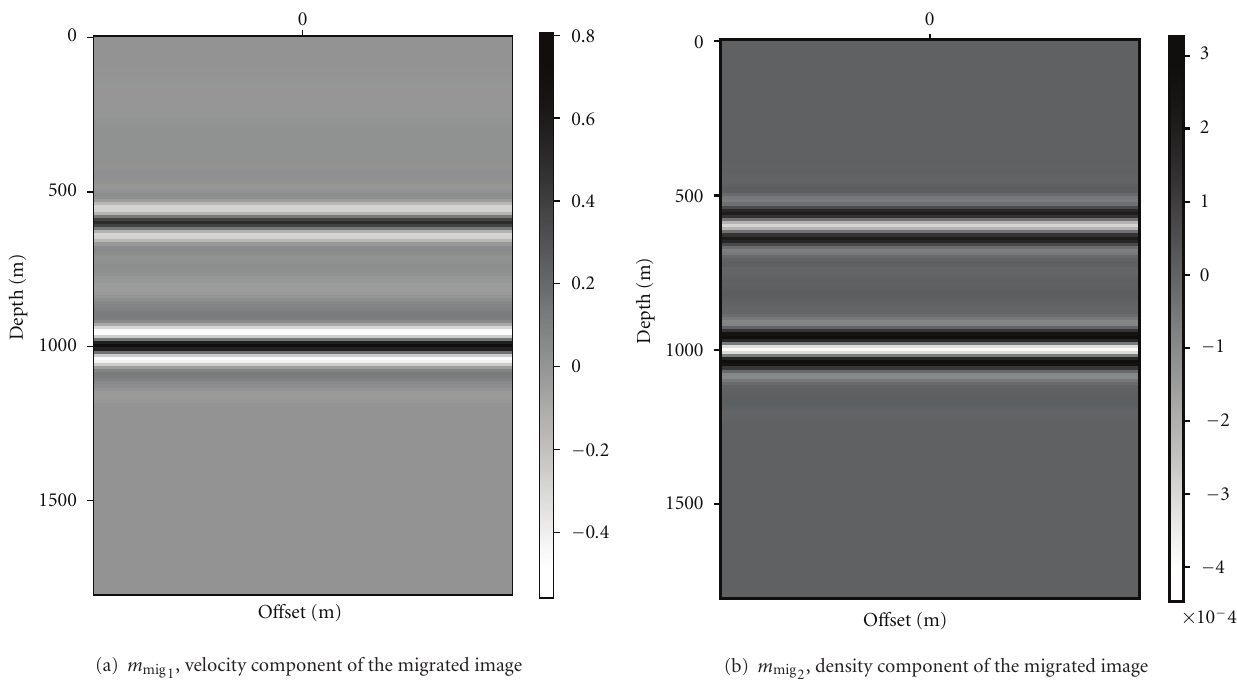
Figure 3: Migrated images mixing the contributions from density and velocity, and e ff ecting a phase space scaling.